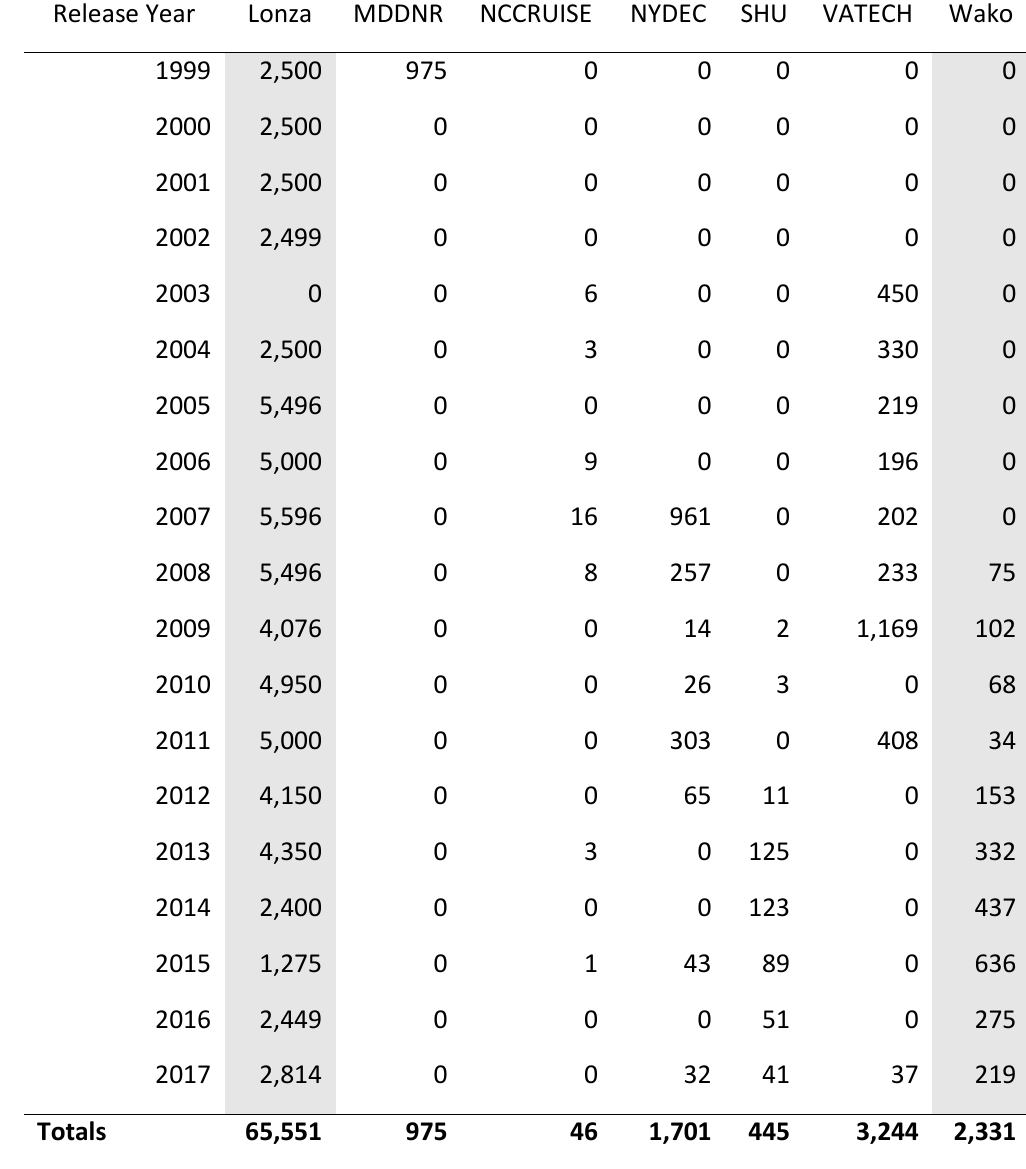
Table 17. All trawl captured horseshoe crabs that have been tagged and released since 1999. Shaded gray columns indicate biomedical companies that tag bled crabs (Lonza and